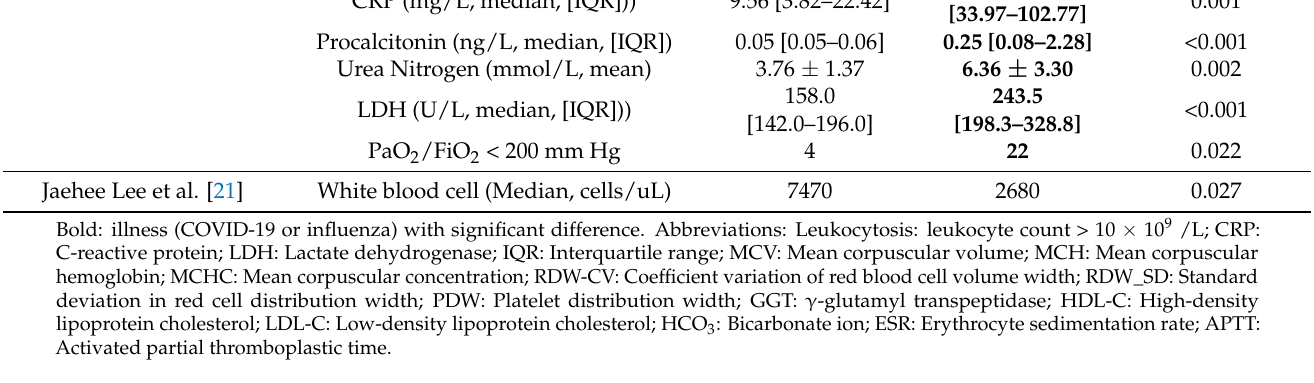
Table 4. Significant radiological findings between COVID-19 and influenza adult